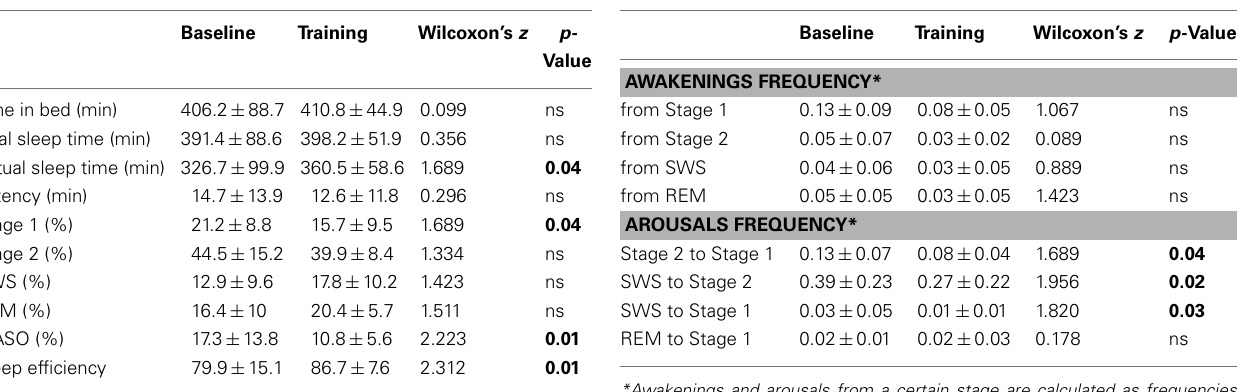
Table 1 | Quantitative sleep variables.